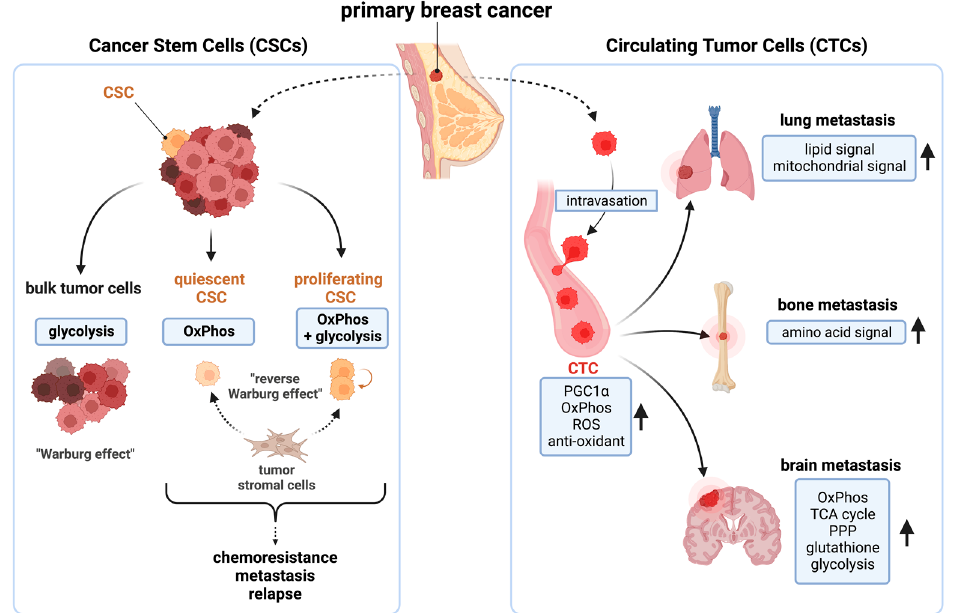
Figure 1. The function of breast cancer stem cells (CSCs) and circulating tumor cells (CTCs) are mitochondria dependent. ( Left ): while bulk cancer cells are glycolysis dependent, CSCs depend on OxPhos for survival. ( Right ): CTC-mediated distant metastases are also dependent on multiple mitochondrial functions. OxPhos: oxidative phosphorylation; PGC1 α : peroxisome proliferator-activated receptor gamma coactivator 1-alpha, ROS: reactive oxygen species; TCA cycle: the tricarboxylic acid cycle; PPP: pentose phosphate pathway. This figure was generated by BioRender.com (19 January 2023).